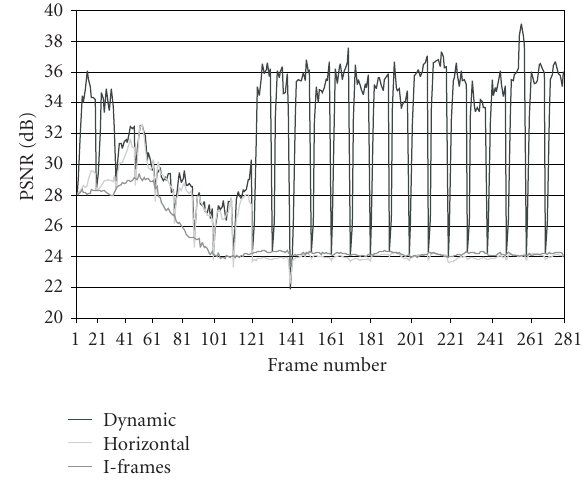
Figure 19: PSNR measures for the coded “table tennis” sequence, where the DCT computation was scaled to compute 32 coe ffi cients. Compared to coding I-frames only (medium gray curve), inter DCT coding results in an improved output quality in case of motion (light gray curve) and even a higher output quality with dynamic interframe DCT